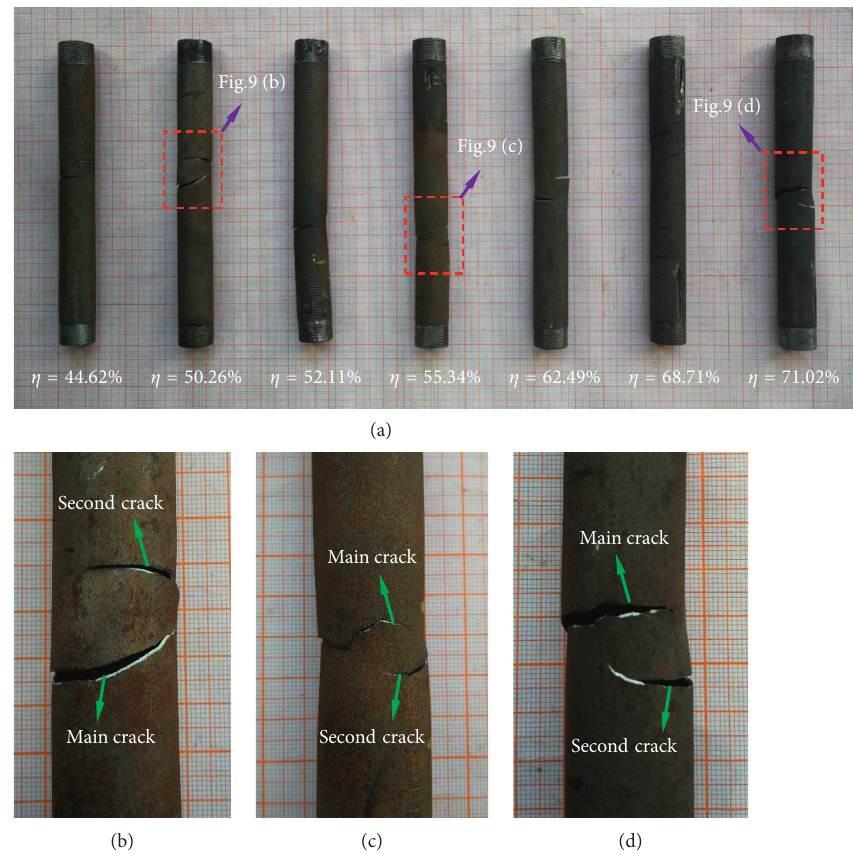
Figure 9: Fracture patterns of corroded pipe with higher corrosion rates.